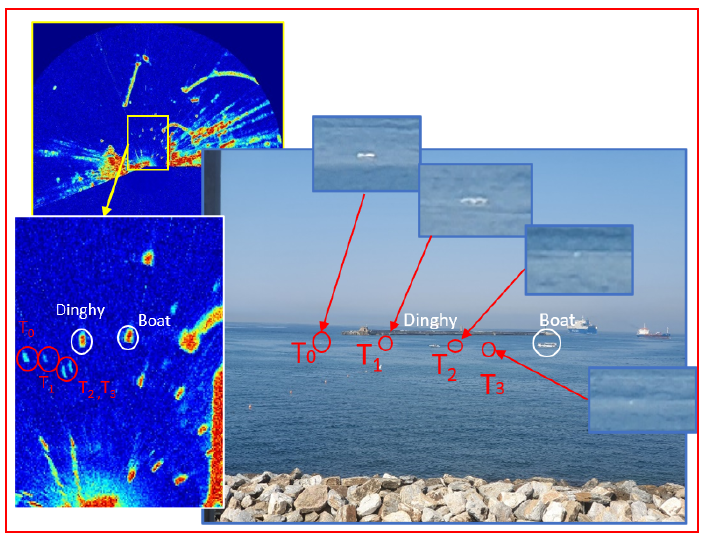
Figure 10 . Radar and photographic representations of the second release of the targets . Figure 10. Radar and photographic representations of the second release of the targets.